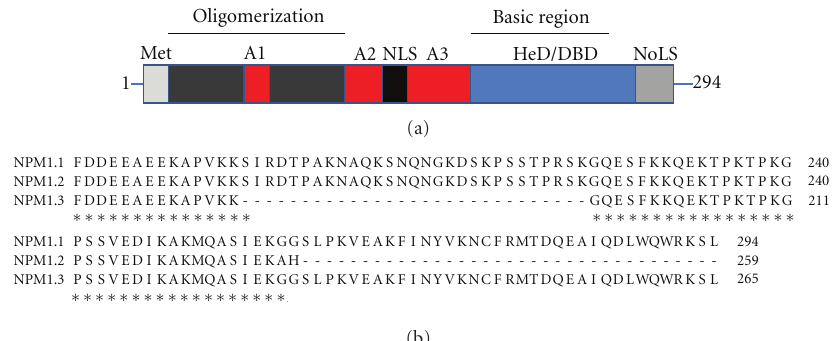
Figure 2: NPM1 domain organization. (a) Detailed domain representation of human NPM1 highlighting oligomerization, acidic, basic regions and where A1–A3 denotes the acidic patches (NLS: nuclear localization signal; HD: heterodimerization domain; DBD: DNA binding domain; NoLS: nucleolar localization motif). (b) Partial sequence alignment of NPM1.1 (wt) and the NPM1.2 and NPM1.3 isoforms illustrating loss of important parts of NPM1.